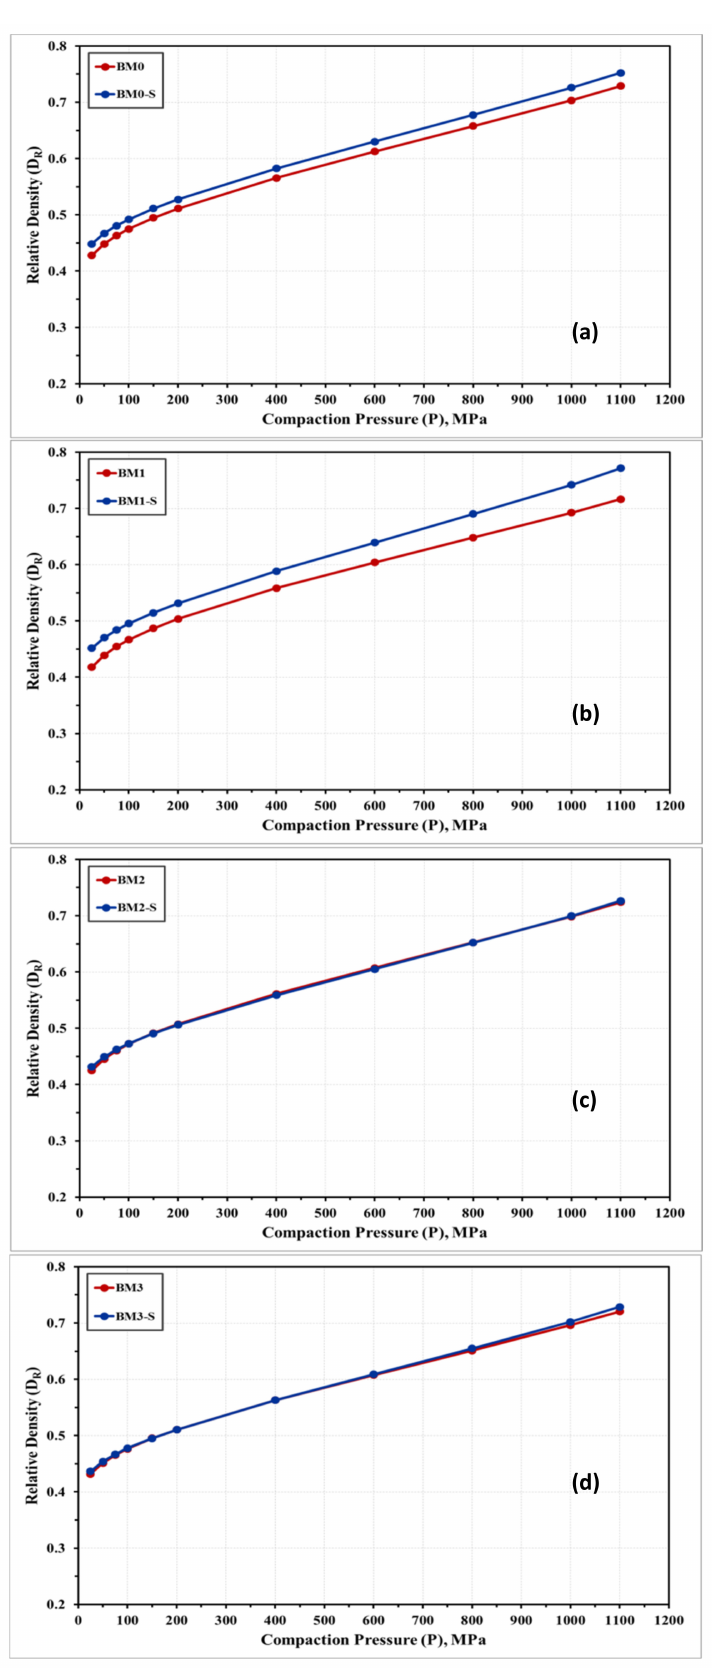
Figure 9. Relative density of ( a ) BM0; ( b ) BM1; ( c ) BM2; and ( d ) BM3 samples in the as-milled vs. stress relieved